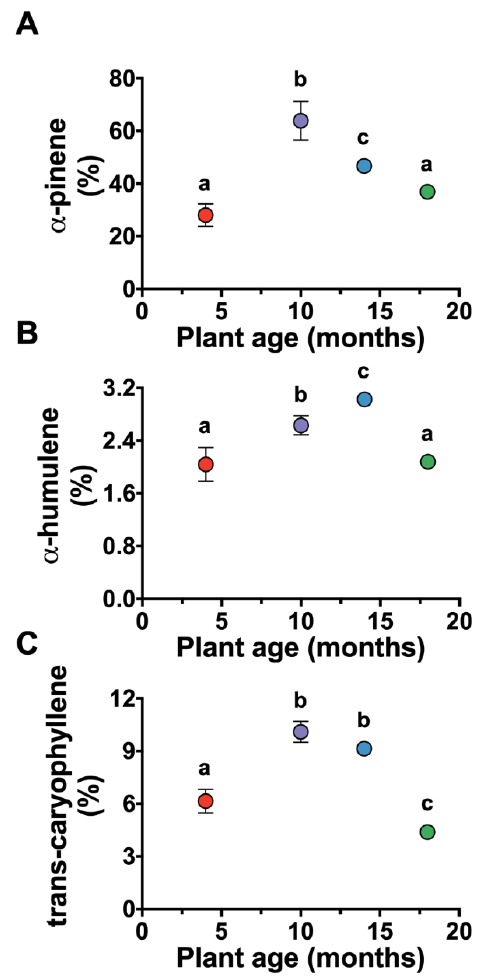
Figure 4. Concentrations of selected compounds in the essential oils extracted from V. curassavica at different ages (4, 10, 14 and 18 months-age) via steam distillation on an industrial scale: ( A ) α -pinene; ( B ) α -humulene; ( C ) trans -caryophyllene. Different letters (i.e., groups not sharing any letter) denote statistically significant differences (one-way ANOVA followed by Tukey’s multiple comparisons test). Data are presented as means ± SDs.